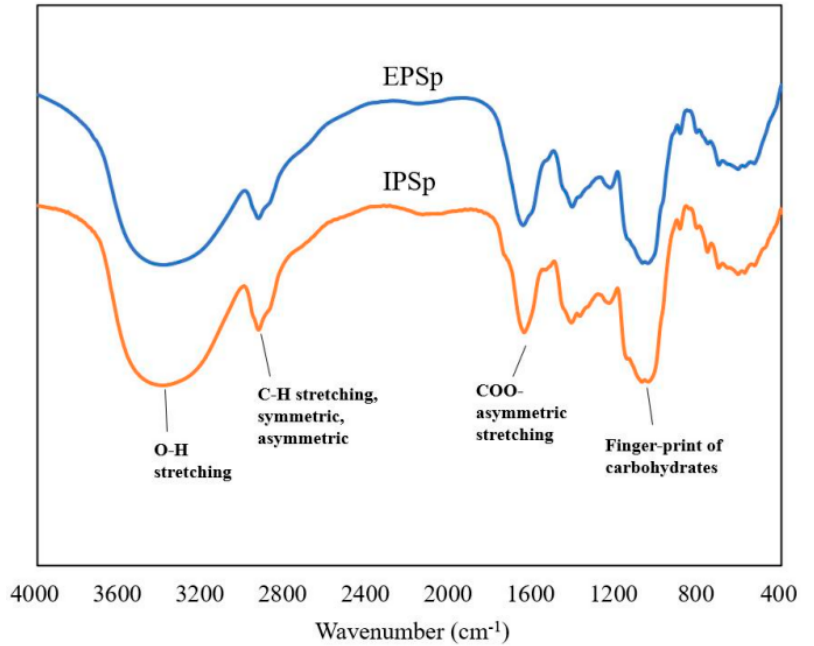
Figure 1. The FT-IR spectra of EPSp and IPSp. EPSp: purified Cs-4 exopolysaccharides, IPSp: purified Cs-4 intracellular polysaccharides.